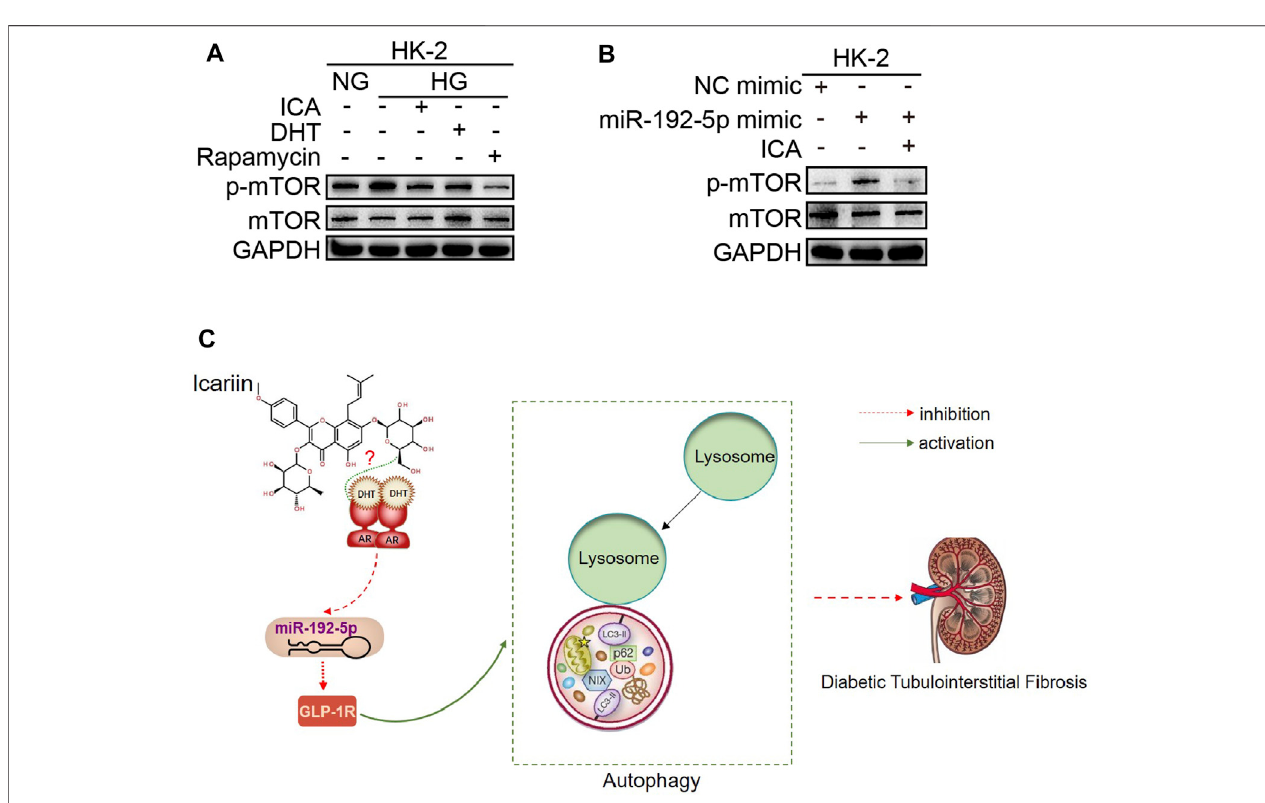
FIGURE 8 | ICA and DHT induce autophagy by reducing phosphorylated mTOR ( p -mTOR) expression (A) The HK-2 cells were stimulated with HG and treated respectively with ICA (50 μ M), DHT (100 nM) and rapamycin (100 nM) for 48 h, the expression of p -mTOR and mTOR was detected (B) The p -mTOR and mTOR expression in HK-2 cells transfected with miR-192-5p mimic and treated with ICA (2 μ M) (C) Mechanisms for the anti-diabetic tubulointerstitial fi brosis effect of ICA.